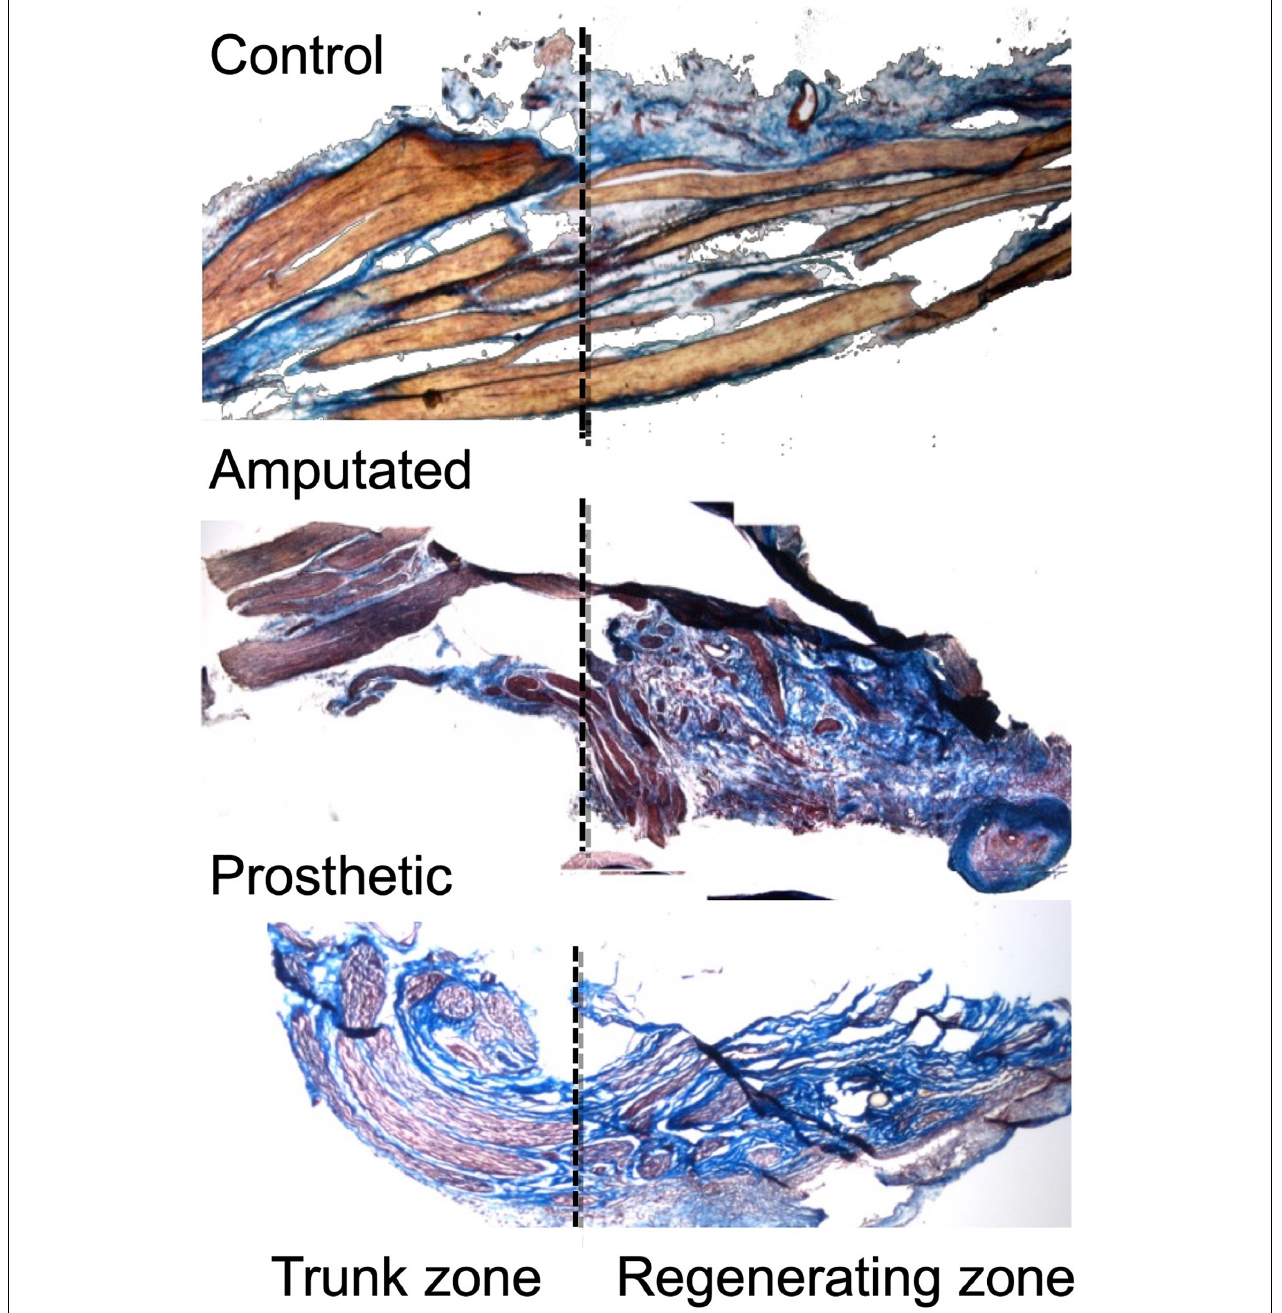
FIGURE 4 | Effects of electric neurostimulation on the macroscopic anatomical structure of an amputated rat trigeminal peripheral nerve (Herrera-Rincon et al., 2011). Masson trichrome staining of nerve tissue from Control, Amputated, and Prosthetic animals. Nerve fibers can be detected as red-stained “bundles” crossing from left to right, surrounded by a blue-stained matrix (mostly collagen). In control nerve (top) the axons are organized in regular fascicles separated by connective tissue, whereas in the amputated nerve (middle) , the regular organization of the tissue is altered. However, whereas in amputated nerves, organization is completely lost with haphazardly arranged axons dispersed inside the connective tissue, in prosthetic nerve (bottom) , the fascicular organization is preserved. The importance of stimulation as a therapy to improve the regeneration of the growing fibers resides in the ability to achieve a guided and organized growth. Through Masson trichrome, we can observe the fascicular organization of the fibers, stained in brown and marked with arrow. In the left side of the images, the “trunk” is shown, the undamaged “proximal” area, which is in charge to activate the biomolecular regenerative processes. In the right, we can observe the regenerated fibers. Here we can see how when no treatment is performed, the tissue is disorganized, with a predominance of connective tissue (stained in blue, marked with arrow), whereas the treatment with electrical stimulation allows a more organized growth, maintaining the fascicular structure throughout the section (marked with arrow). Original magnification 100 × . ©[2011] IEEE. Reprinted, with permission, from IEEE Proceedings.